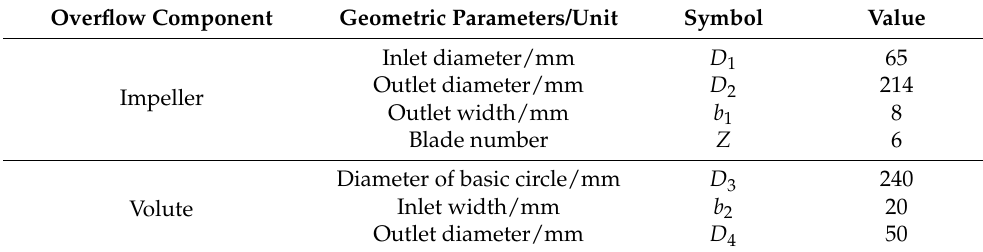
Table 1. The main geometry parameters of ballast pump.